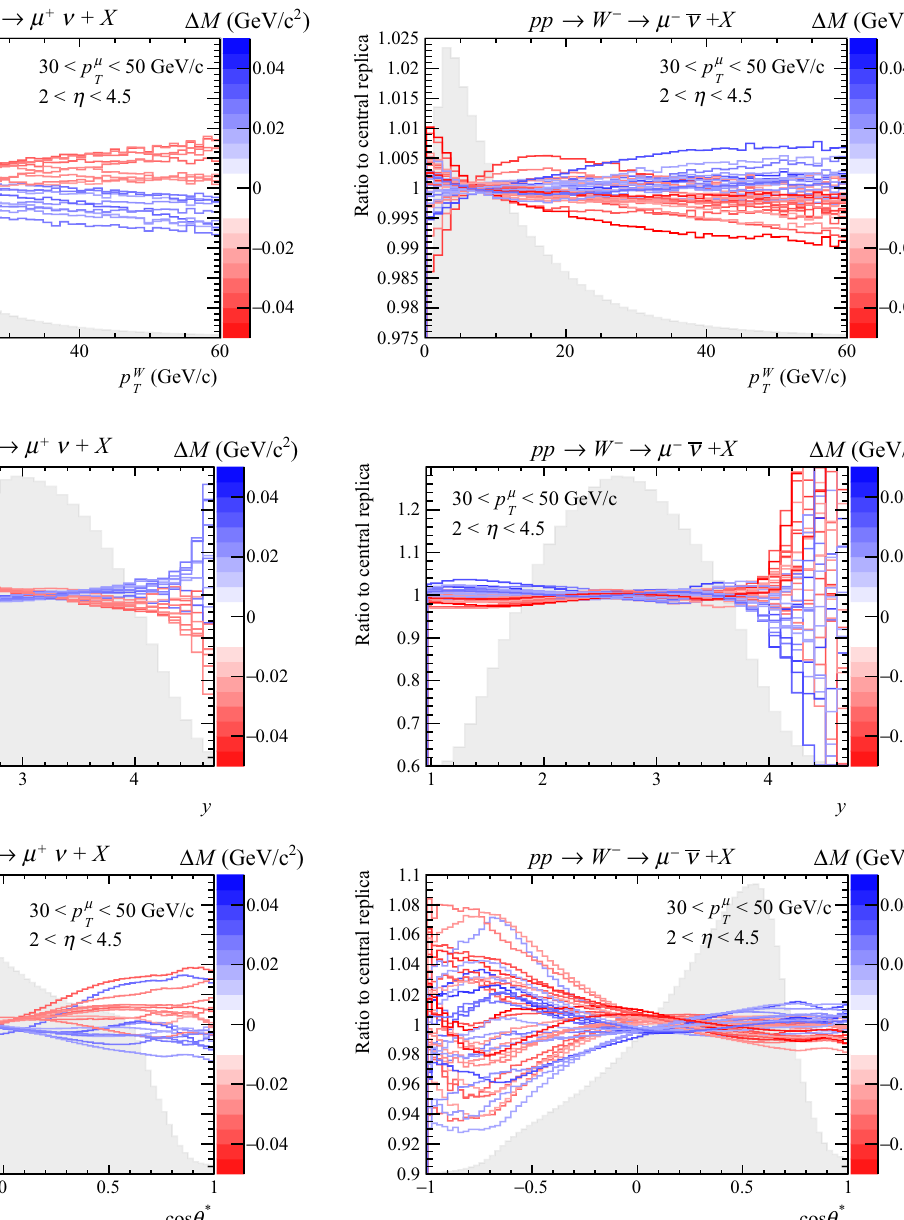
Fig. 5 The variations in the shapes of the p W tionspredictedwithasubsetofNNPDF3.1replicas.Eachlineismarked with a colour indicating the shift of the M W value determined from a